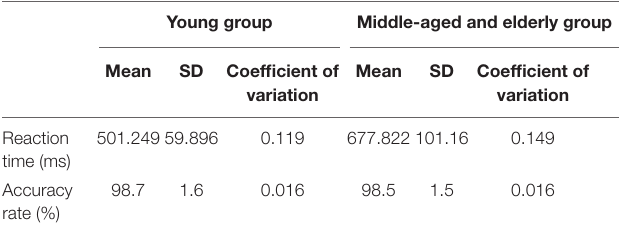
TABLE 2 | Results of reaction time and accuracy rate on flanker tasks of all participants.